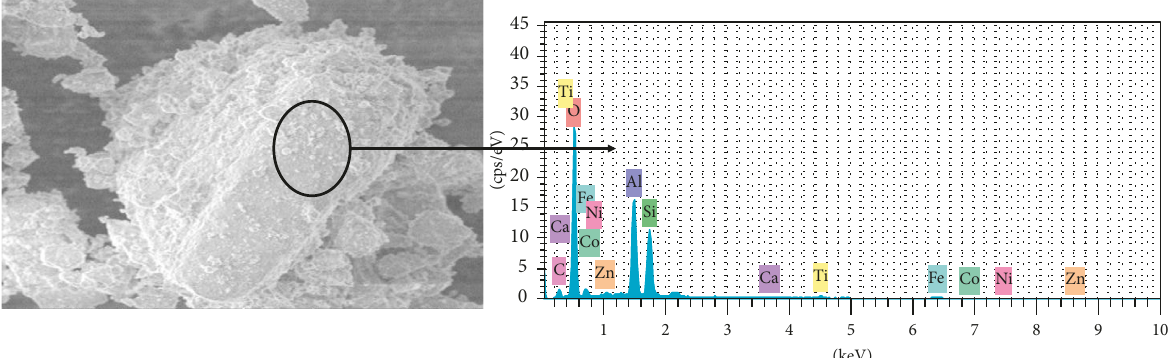
Figure 4: Energy-dispersive X-ray (EDX) analysis of